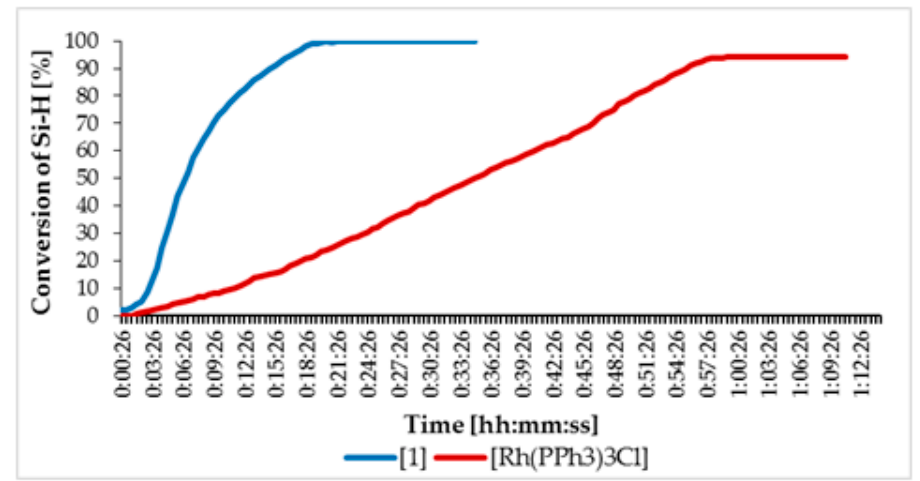
Figure 1. The dependence of the conversion of Si–H on time for the reaction of 1-octyne with 1,1,1,3,5,5,5-heptamethyltrisiloxane in the presence of catalyst 1 and Wilkinson’s catalyst.